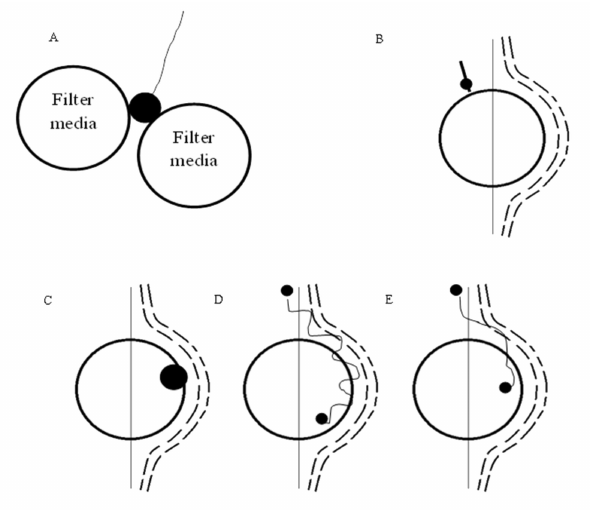
Figure 3. Transport mechanisms in water filtration: ( A ), straining; ( B ), sedimentation; ( C ), interception; ( D ), di ff usion; ( E ), hydrodynamic (reprepared using the data from